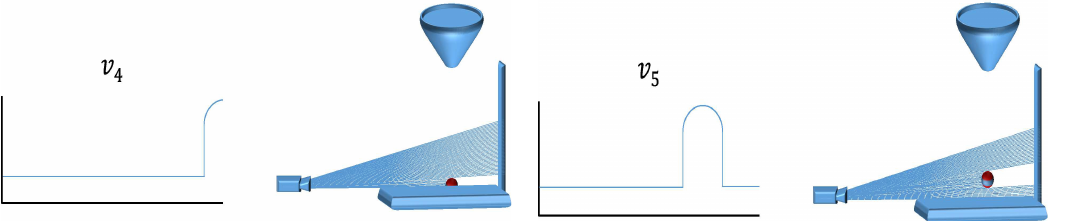
Time t 3 . The marble covered by the beam-projecting area. Some beams hit the entered marble and the rest of the beams hit the white sticker.